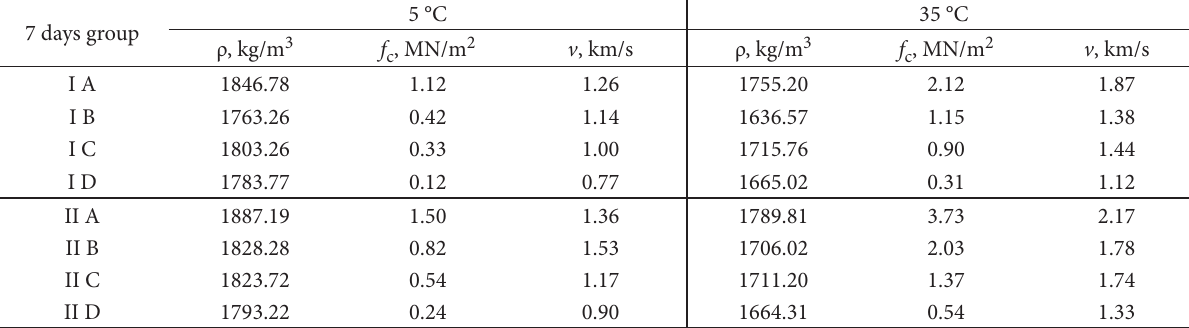
Table 1. The results of density, compressive strength and ultrasonic velocity